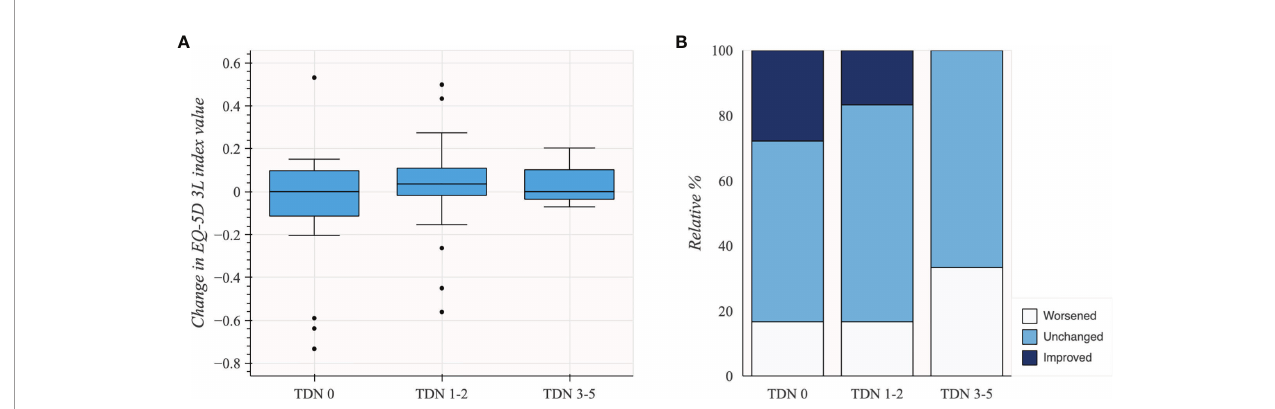
FIGURE 4 | Change in the EQ-5D 3L index value in subgroups of patients based on TDN scores ( N = 45). (A) Box plot illustrating distribution of change in EQ-5D 3L index values. (B) Stacked bar plot illustrating change in EQ-5D 3L based on